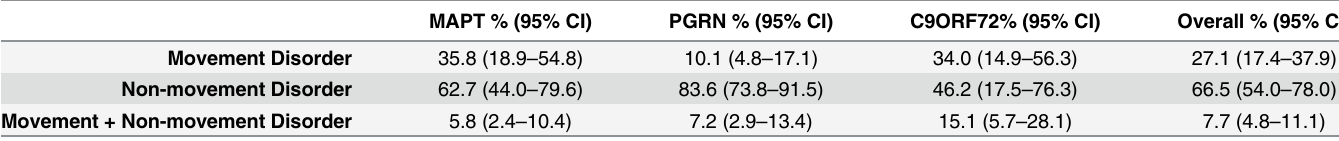
Table 3. Initial Presentation stratified based on genetic subgroup.